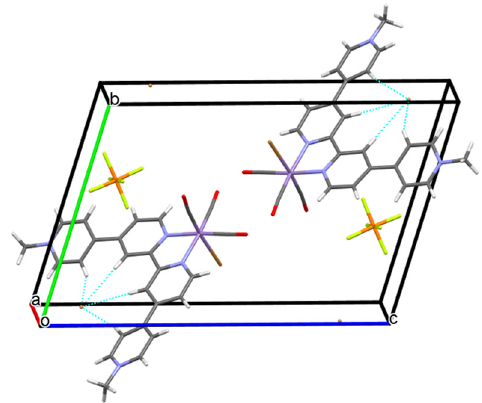
Figure 6. Crystal packing of [MnBr(CO) 3 (dmqpy)]Br(PF 6 ) with the C–H ... Br hydrogen bonds indicated by blue dashed lines.